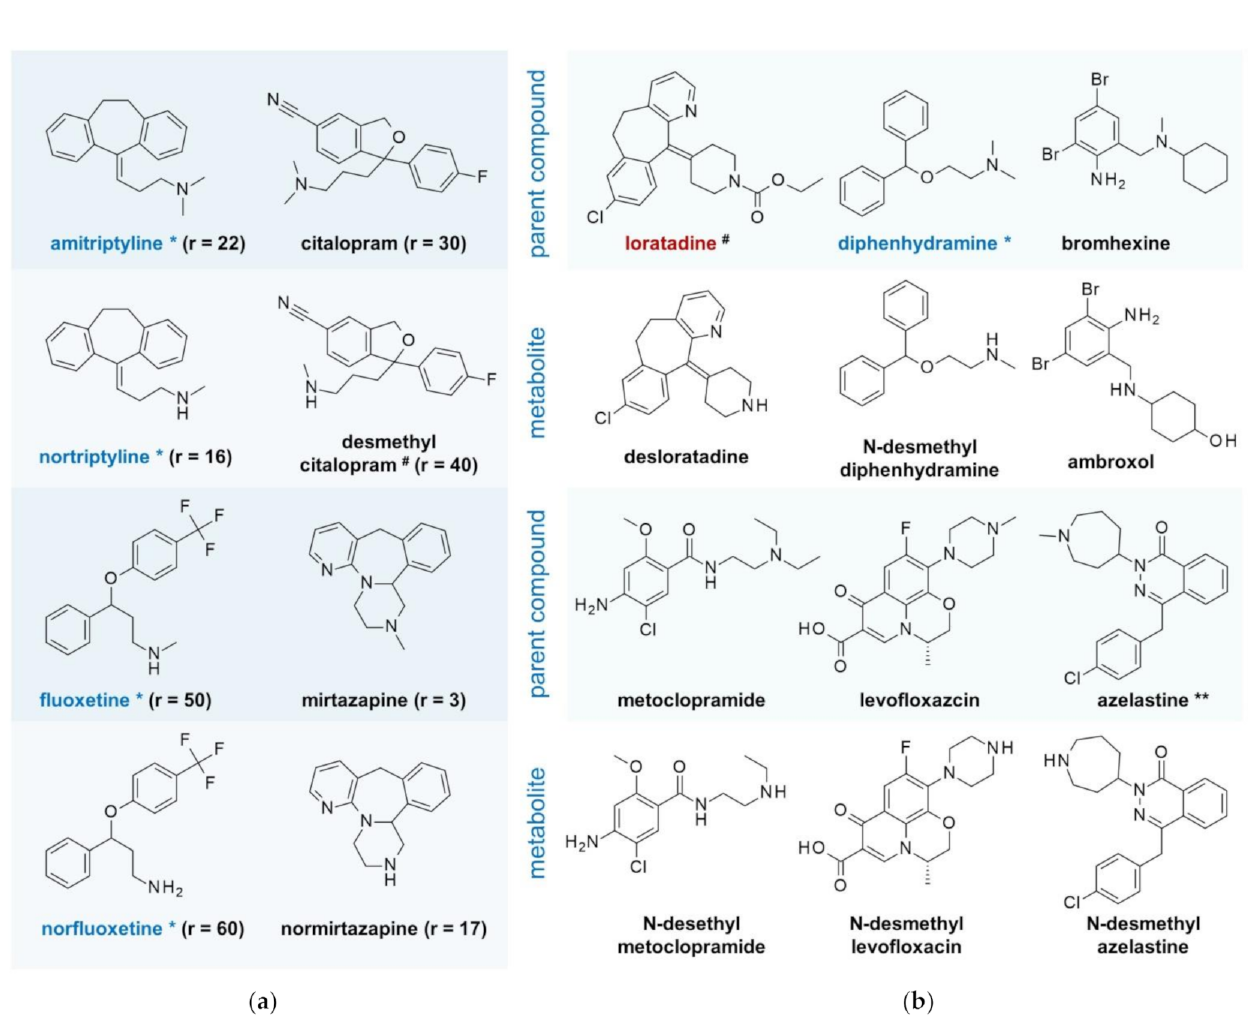
Figure 2. Lysosomotropic candidates and pulmonary tissue accumulation: ( a ) pairs of confirmed (blue colored) and potential lysosomotropic drugs and their N-desmethyl metabolites with proved enrichment in pulmonary tissue (ratio of pulmonary tissue/plasma concentration r > 1) [40–42]. ( # ) Ratio determined in rats, (*) lysosomotropism is confirmed [26]; ( b ) candidates for (systemic) prophylaxis of viral infection and transition to COVID-19. The over-the-counter drugs bromhexine, ambroxol, loratadine, desloratadine, azelastine, and diphenhydramine are assumed to contribute significantly to viral infection prophylaxis and frequency in less affected countries such as Germany. Unless indicated, lysosomotropism is highly probable, but not confirmed. (*) lysosomotropism is confirmed, ( # ) no lysosomotropism, (**) nasal and ophthalmic H 1 -antihistamine. Levofloxacin exhibits anti-inflammatory effects on prominent inflammatory messengers in mice with LPS-induced acute lung injuries [43], comparable to NB 06 in LPS-induced inflammation